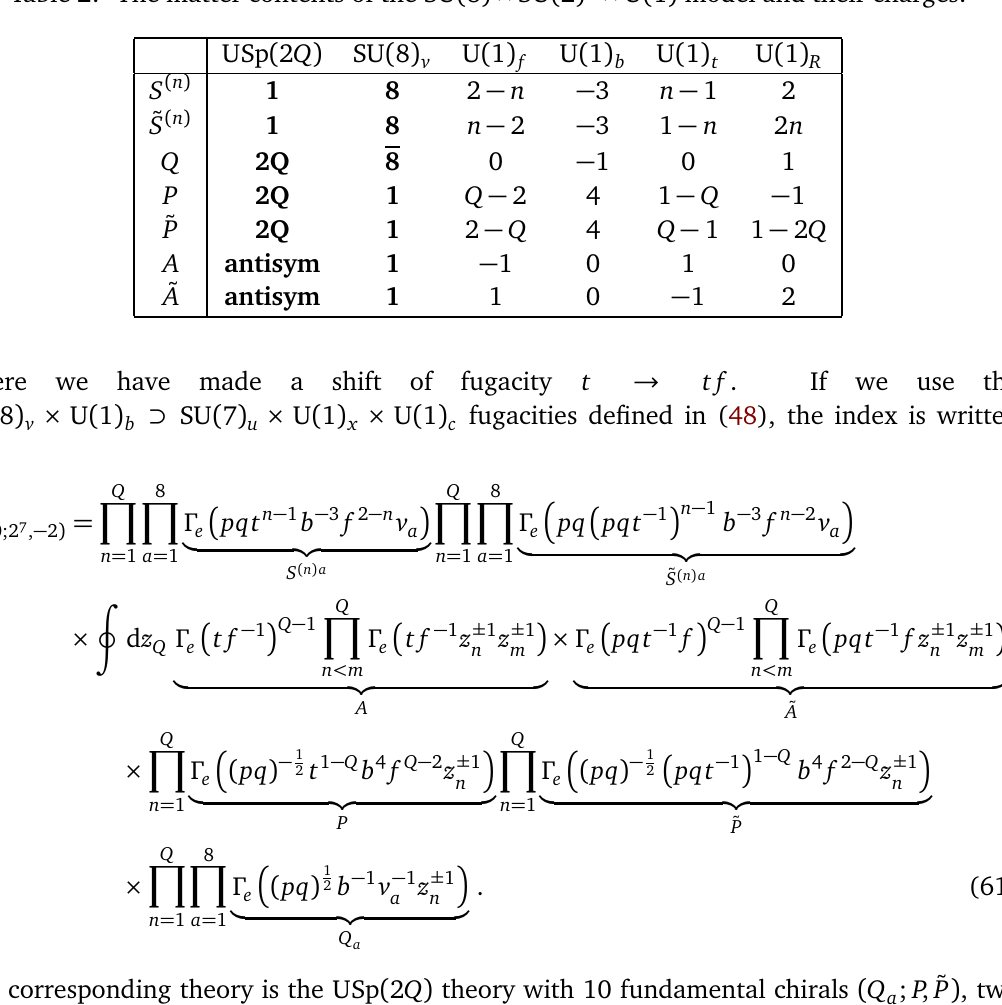
Table 2: The matter contents of the SU ( 8 ) × SU ( 2 ) 2 × U ( 1 ) model and their